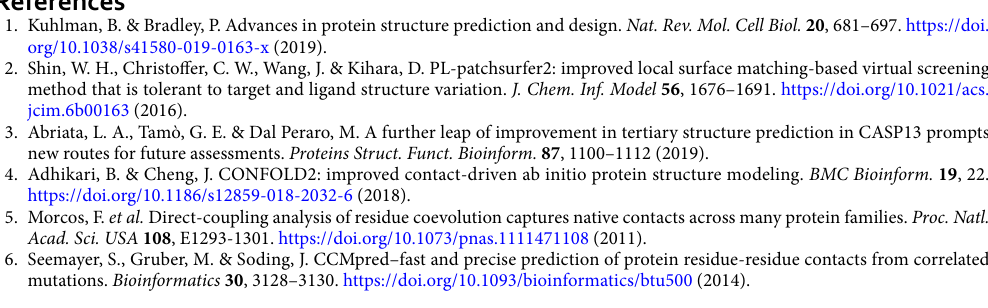
Code availability